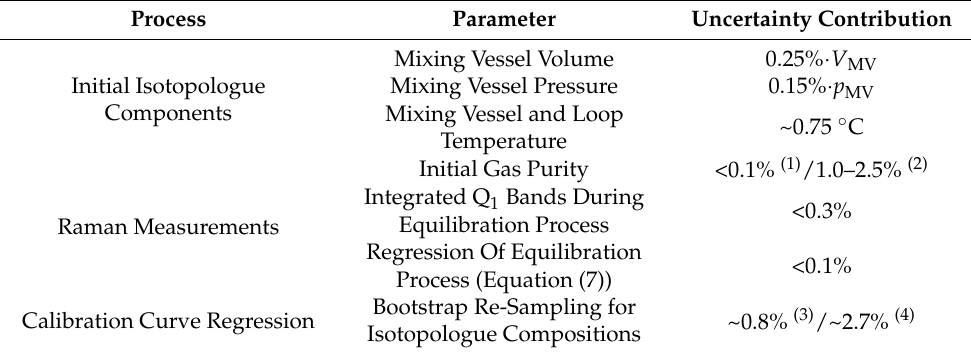
Table 4. Overview of typical uncertainty contributions during extraction of the calibration factors, as applicable to the data sets shown in Figure